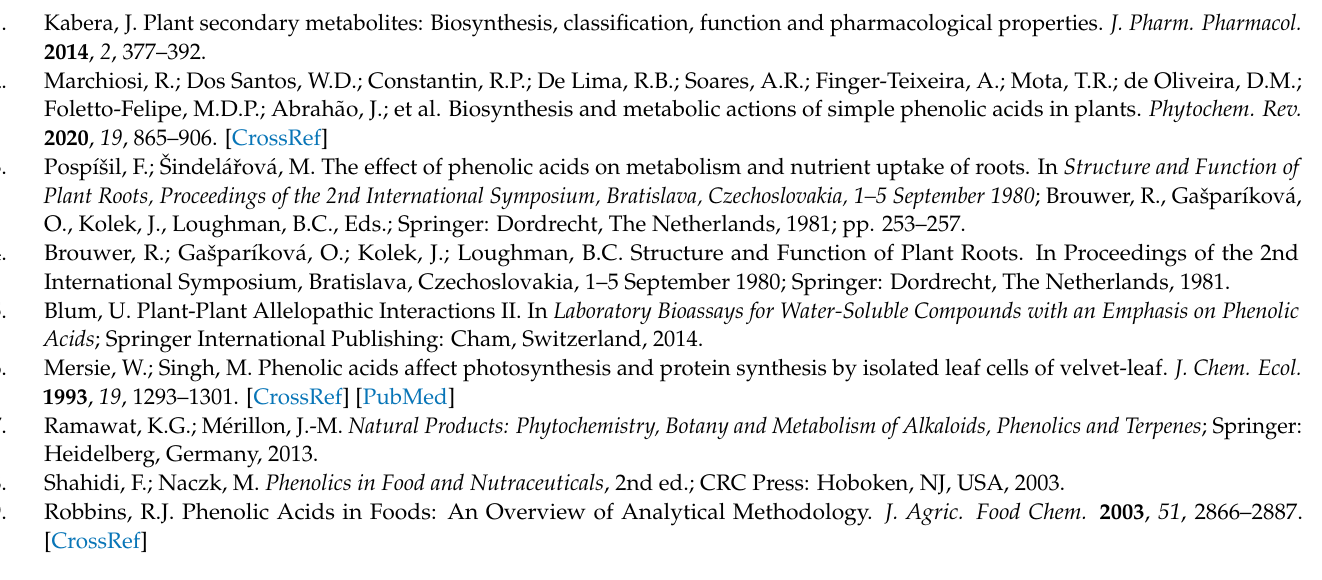
Table S1. Optimization of the [C 6 -bis-VIM] [Br] crosslinked polymer; Table S2. Conditioning solution; Table S3. Eluting solution; Table S4. Calibration results 25–250 mg L − 1 ; Table S5. Calibration results LOD and LOQ; Table S9. Adsorption time profiles; Table S10. Differently crosslinked polymers; Table S11. Sorption capacity; Table S12.